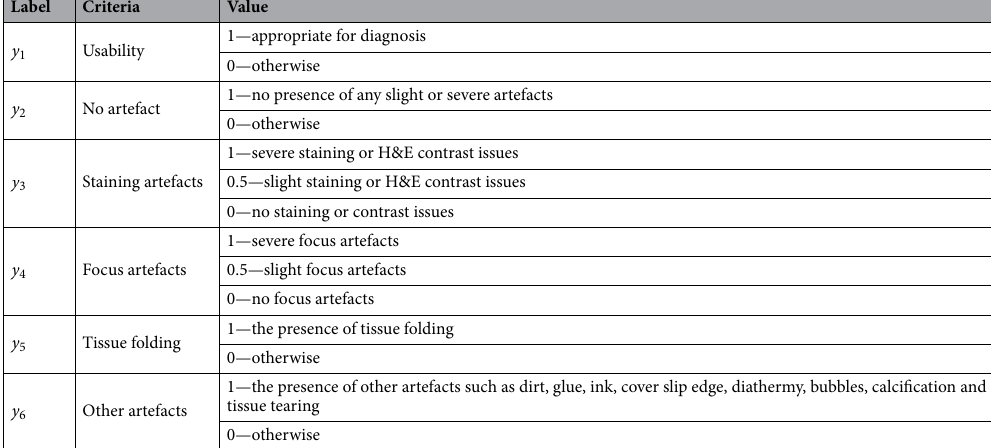
Table 1. Patch level labels. The proposed annotation protocol captures that a given image patch can be corrupted by multiple different artefacts. This protocol also captures if an image patch is diagnostically usable despite being affected by some